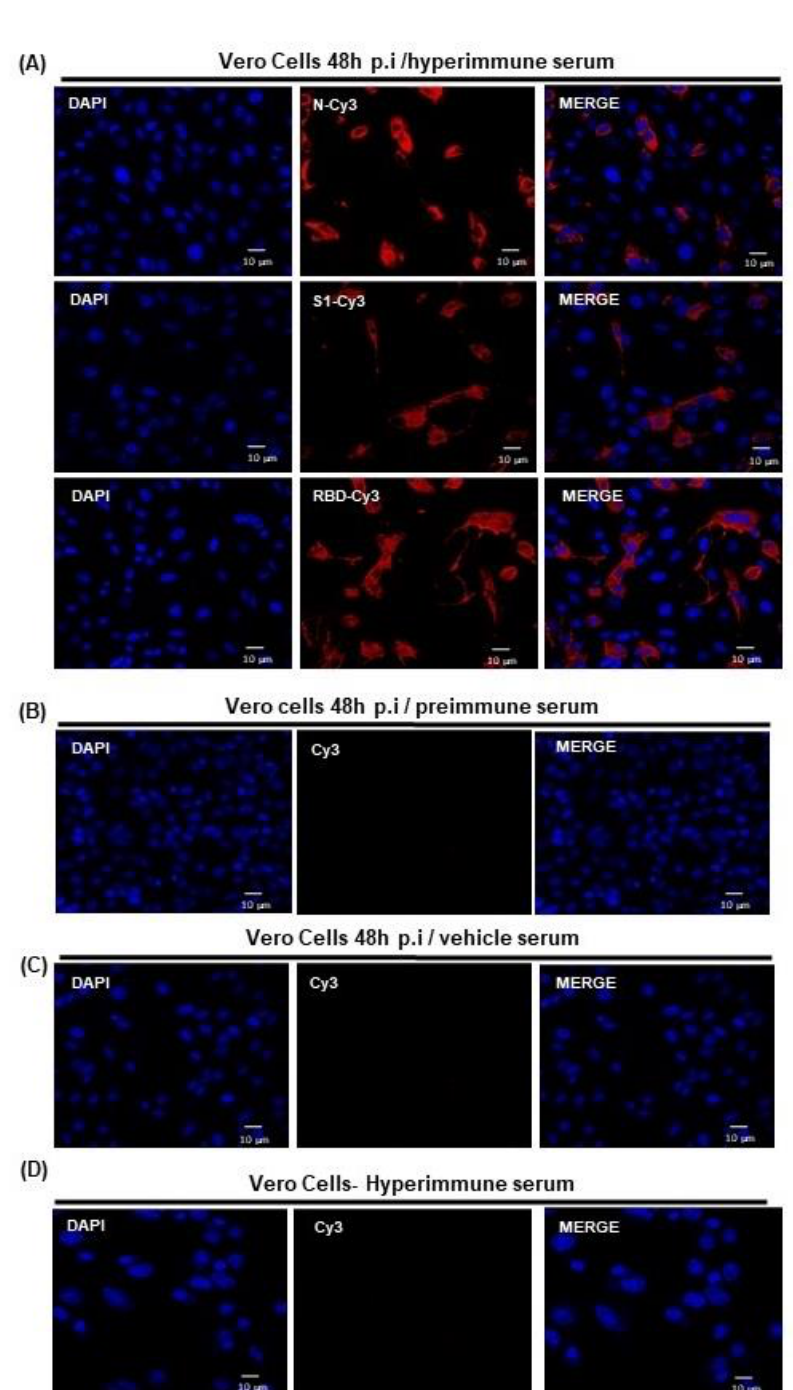
Figure 2. Immunofluorescence assays on SARS-CoV-2-infected Vero cells using sera from mice immunized with recombinant proteins. ( A ) SARS-CoV-2-infected Vero cells were exposed to pooled hyperimmune sera from mice immunized with SARS-CoV-2 recombinant proteins N, S1, and RBD, which were used as primary antibodies and visualized using a Cy3-conjugated goat anti-mouse IgG secondary antibody. Perinuclear and cytoplasmic distribution of N and of S1 and RBD, respectively, can be visualized. ( B , C ) Infected cells were analyzed using a pool of preimmune sera and sera from mice immunized with the vehicle alone. No recognition signal was observed. ( D ) Uninfected Vero cells incubated with hyperimmune sera also did not show localization of any of these